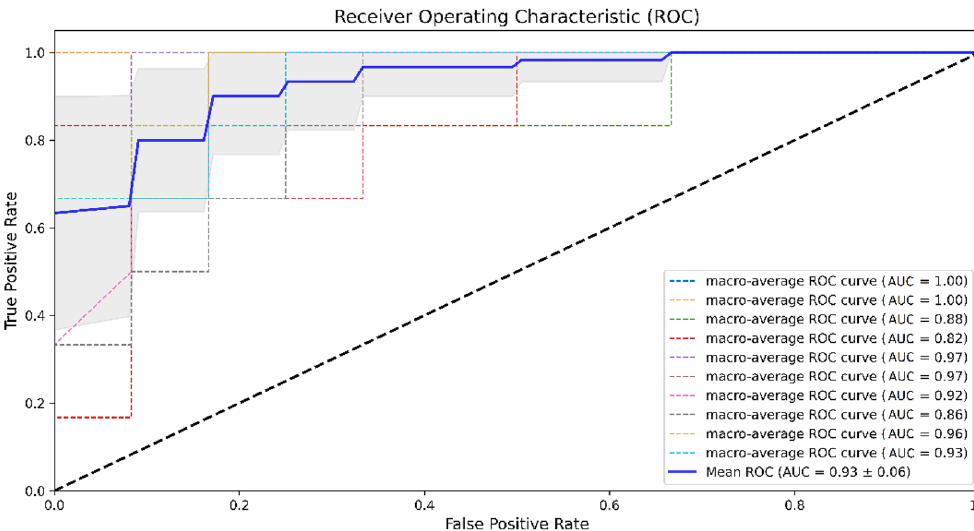
Figure 4. ROC-AUC of the stacking ML model using selected features by RFE.